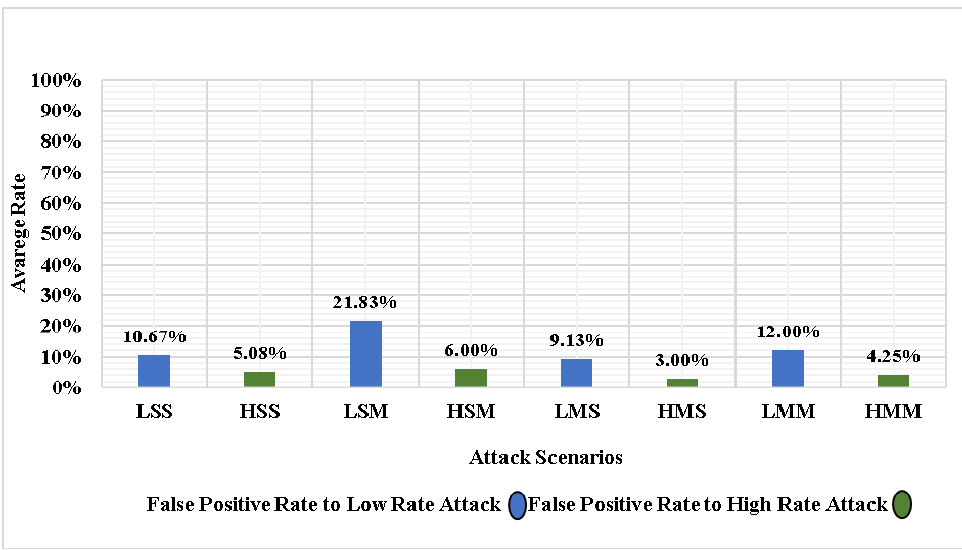
Figure 6. Comparison of the FPR of low-rate attack and high-rate attack in using simulation sce- narios.